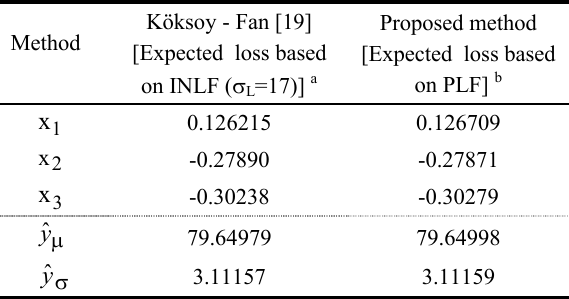
Table 3. Comparison of the optimal results based on expected loss for the catapult problem Method